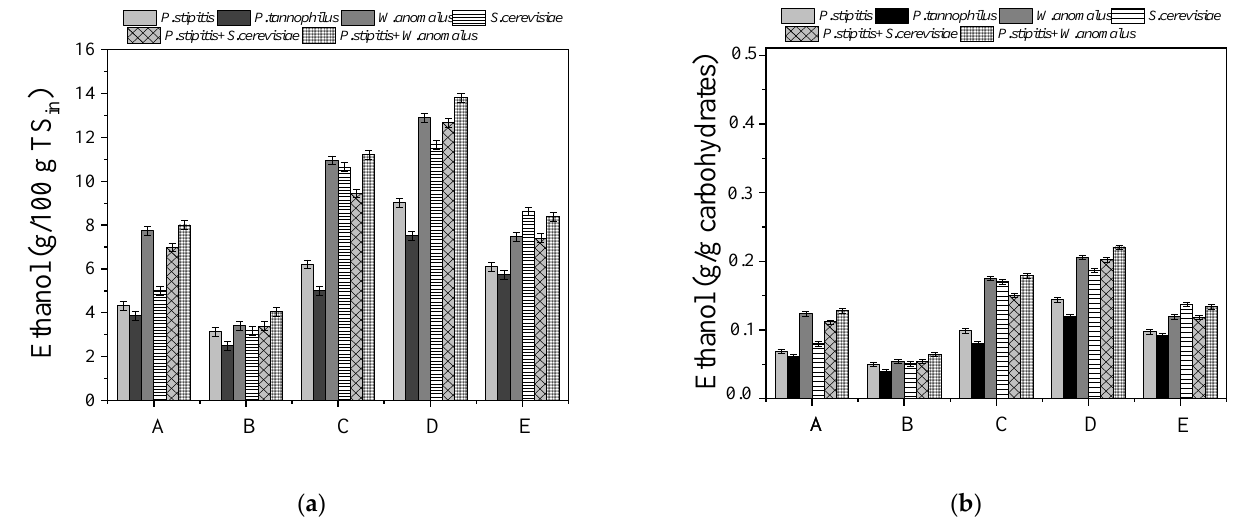
Figure 7. Ethanol yields expressed as ( a ) g/100 g TS in (in: initial biomass) and ( b ) g/g, obtained after 48 h of fermentation of the whole pretreatment slurries, using Pichia stipitis, Pachysolen tannophilus, Wickerhamomyces anomalus X19, Saccharomyces cerevisiae, co-culture of Pichia stipitis with Saccharomyces cerevisiae and Pichia stipitis with Wickerhamomyces anomalus X19. Regarding pretreatments, (A) NaOH (0.5% w / v ), (B) H 2 O 2 (0.5% v / v ), (C) mixture of NaOH (0.5% w / v ) and H 2 O 2 (0.5% v / v ) at ratio 1:1, (D) initially NaOH (0.5% w / v ) followed by H 2 O 2 (0.5% v / v ), and (E) initially H 2 O 2 (0.5% v / v ) followed by NaOH (0.5% w / v ).